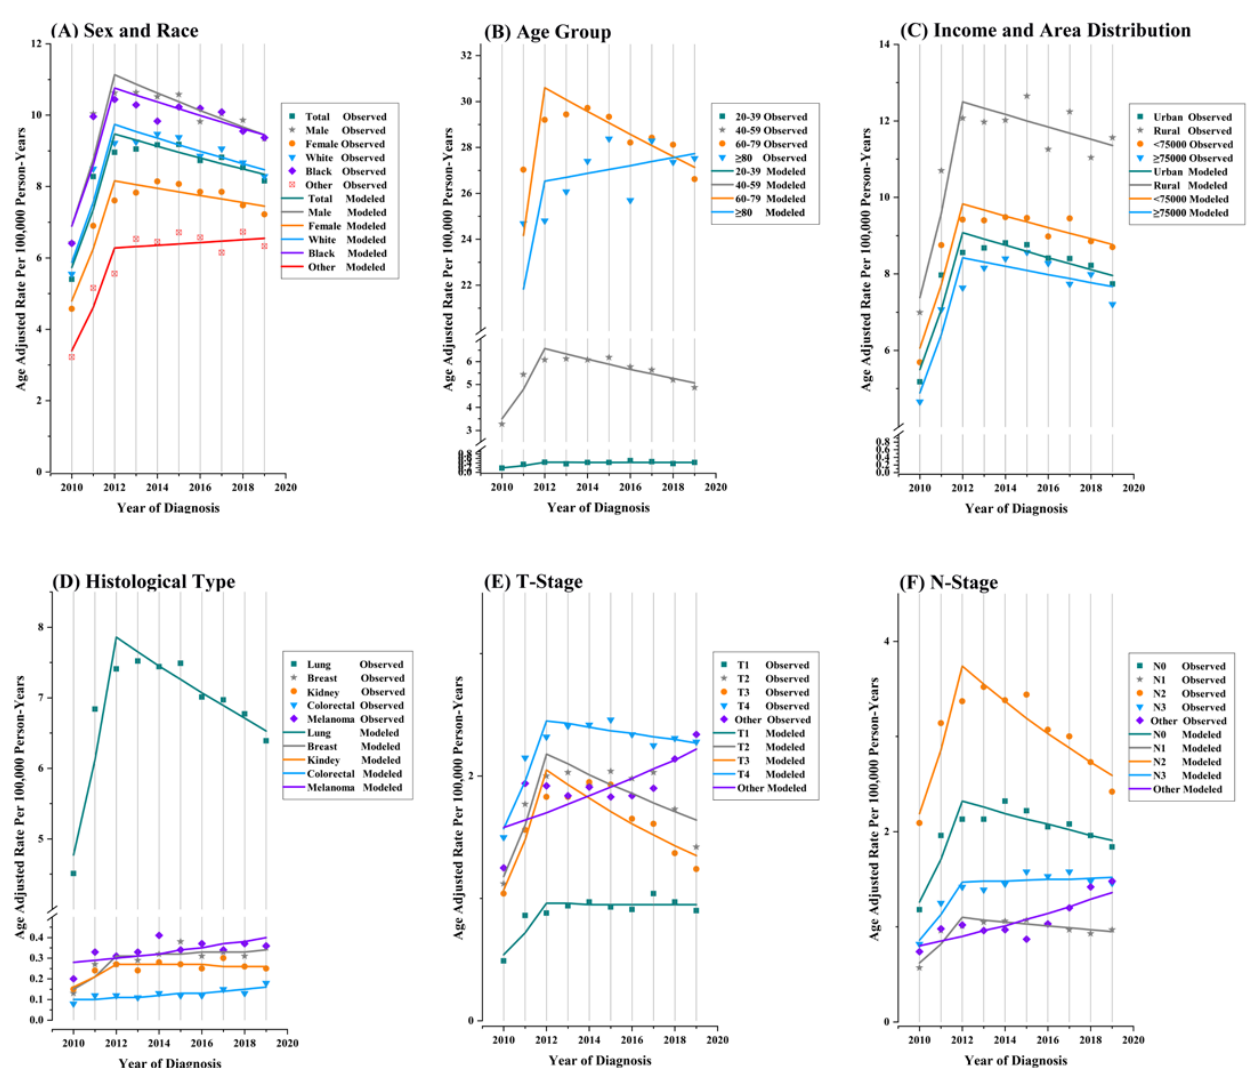
Figure 3. Trends in annual synchronous-brain-metastasis-incidence-based mortality rates by sex and race ( A ), age ( B ), median household income and area distribution ( C ), primary tumor site ( D ), T-Stage ( E ) and N-Stage ( F ). All rates presented were age-adjusted based on the 2000 U.S. standard population (cases per 100,000 person-years). Each segment on the line represents the annual percent change (APC).